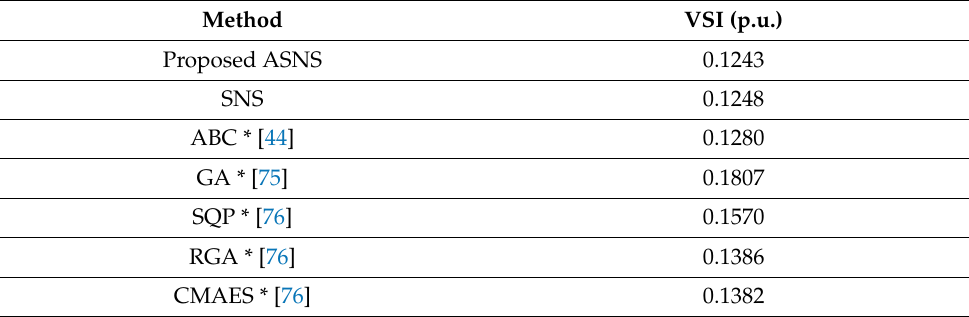
Table 5. Comparative results for Case 3 of the IEEE 30-bus